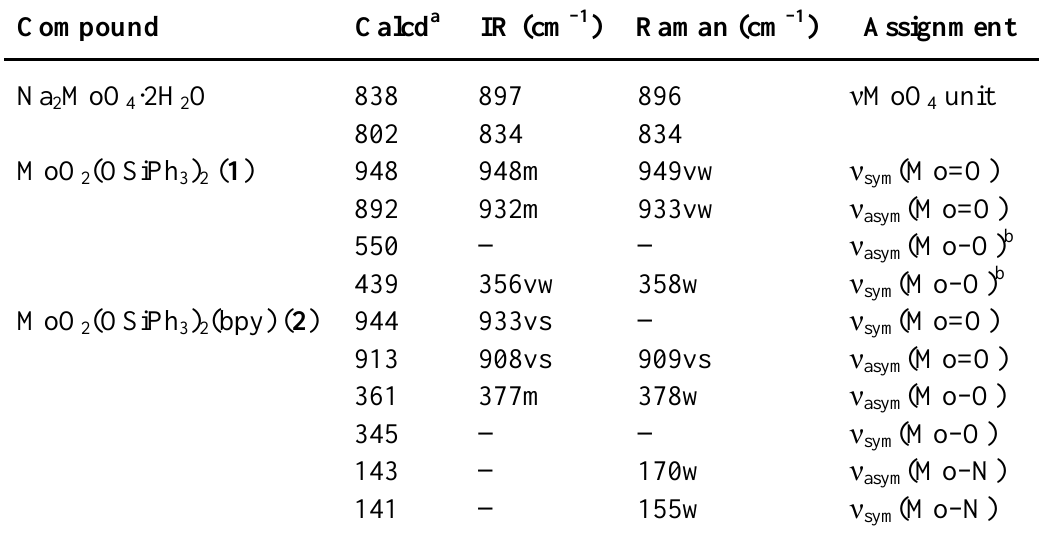
Selected IR and Raman stretching frequencies of Na MoO (OSiPh ) ( 1 ) and MoO 2 3 2 frequencies of the three compounds. Compound Calcd